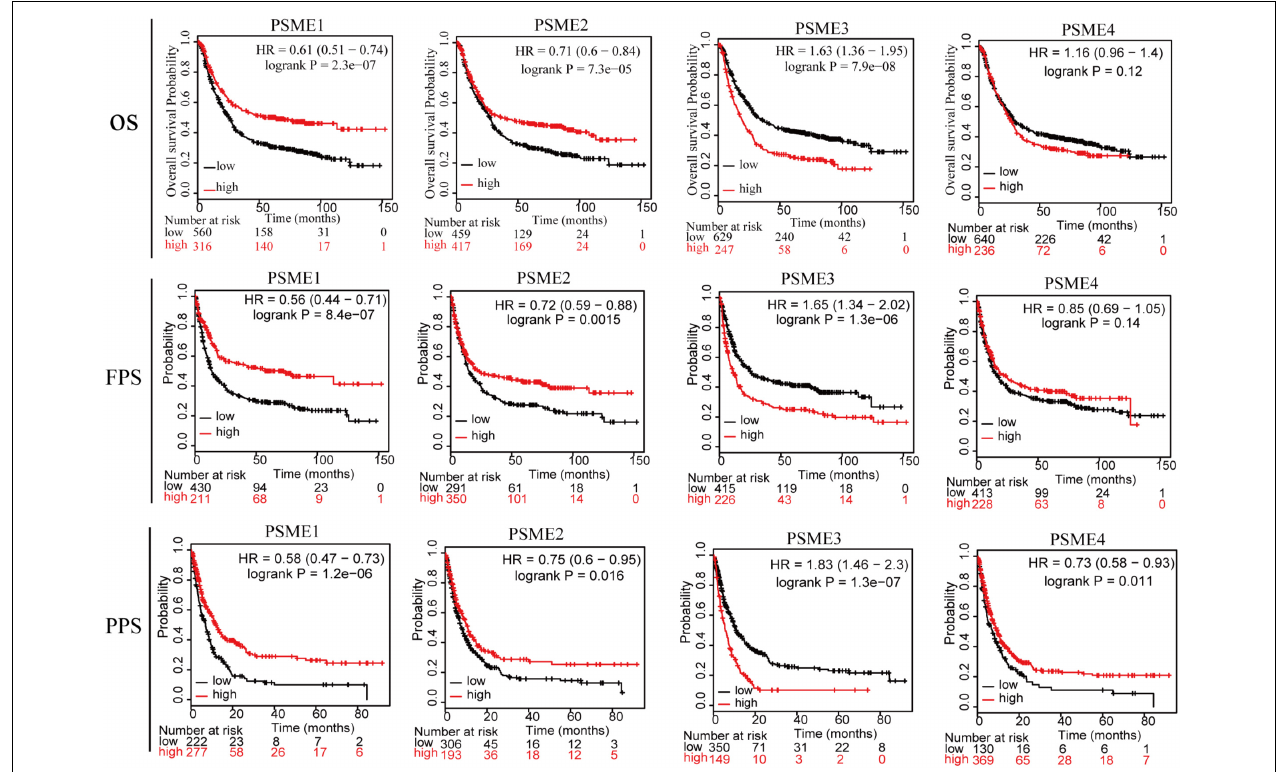
FIGURE 3 | The relationship between the expression levels of the PSME genes and prognosis of GC patients (Kaplan–Meier plotter database). PSME, proteasome activator subunit; OS, overall survival; FPS, first progression survival; and PPS, post-progression survival. Logrank P was set at